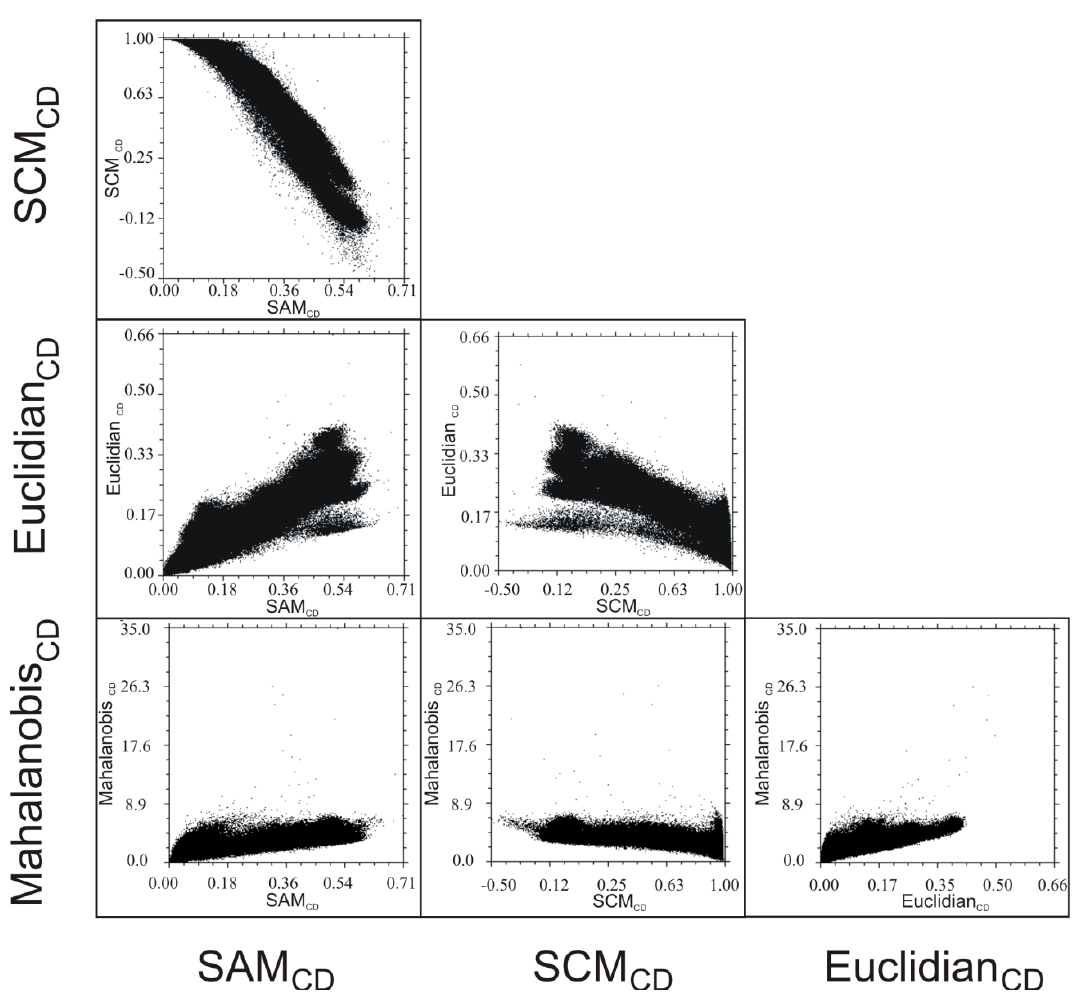
Figure 8. Bivariate scatter diagrams for change-detection (CD) measure images: Spectral Angle Mapper (SAM ), Spectral Correlation Mapper (SCM CD Mahalanobis